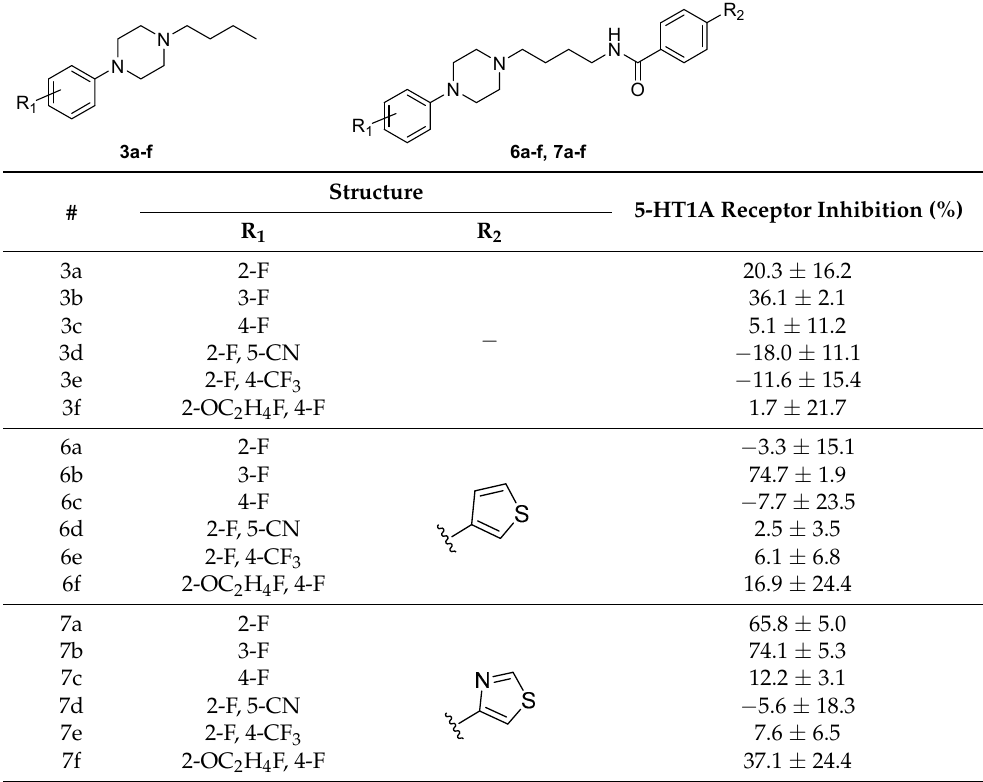
Table 2. Screen for Binding Affinity at the 5-HT1A Receptor.